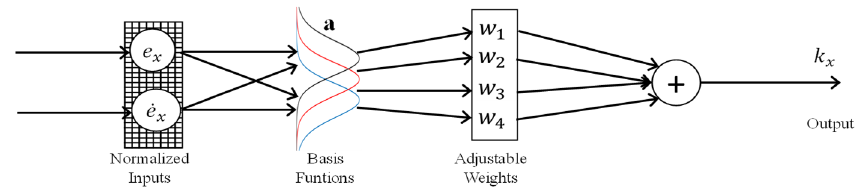
Figure 2. B-Spline neural networks structure.